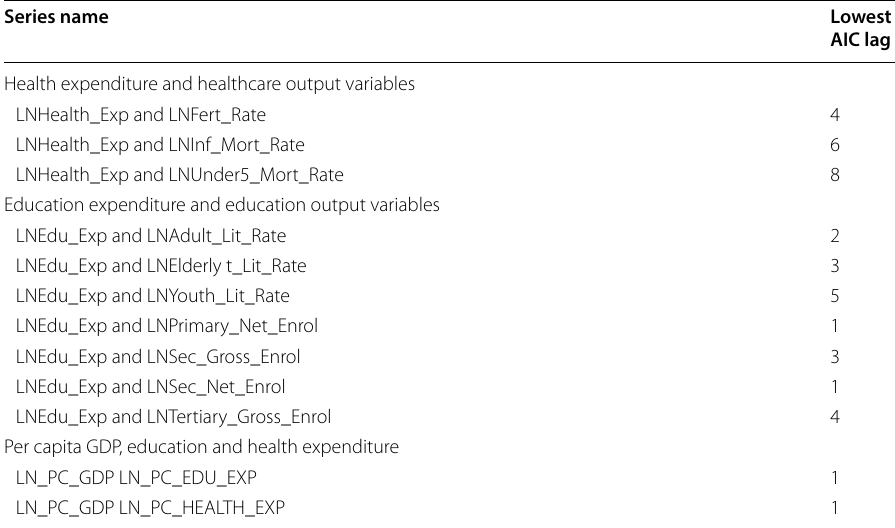
Table 2 Optimal lag selection for co-integration